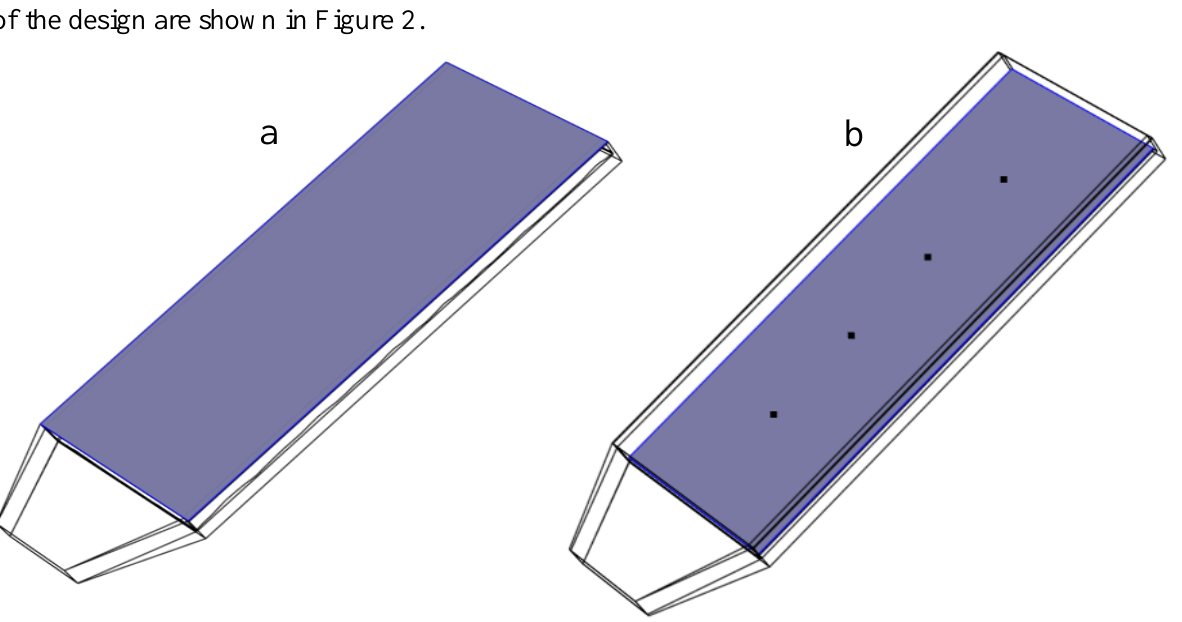
Figure 2. an optical system consists of (a) glass cover, (b) absorber